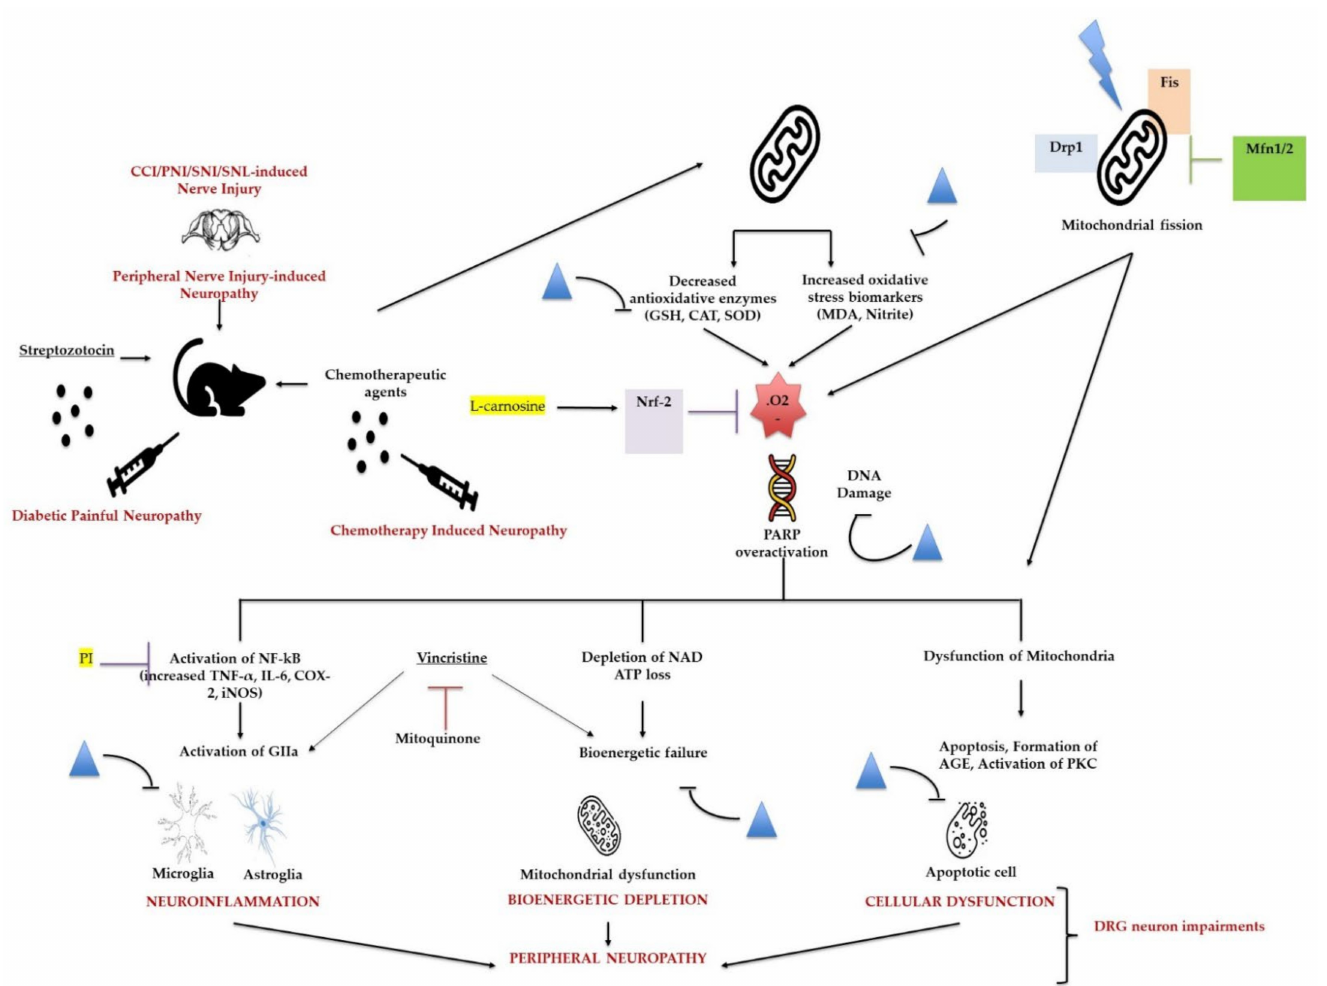
Figure 3. The effects of flavonoids and mitoquinone on neuropathic pain induced by vincristine. Flavonoids attenuate different peripheral neuropathic pain conditions by inhibiting or downregulat- ing different neuroinflammatory, cellular, bioenergetic, and oxidative stress markers. Mitoquinone alleviates vincristine-induced neuropathic pain by improving mitochondrial dysfunction and inhibit- ing oxidative stress and apoptosis. Flavonoids; Nrf-2: nuclear factor erythroid 2–related factor 2; Drp-1: dynamin-related protein 1, Fis: mitochondrial fission protein; Mfn: mitofusin; .O2: reactive oxygen species/superoxide anion; PARP: poly(ADP-ribose) polymerase; NAD: nicotinamide adenine dinucleotide; AGE: advanced glycation end products; PKC: protein kinase C; PI: proteasome